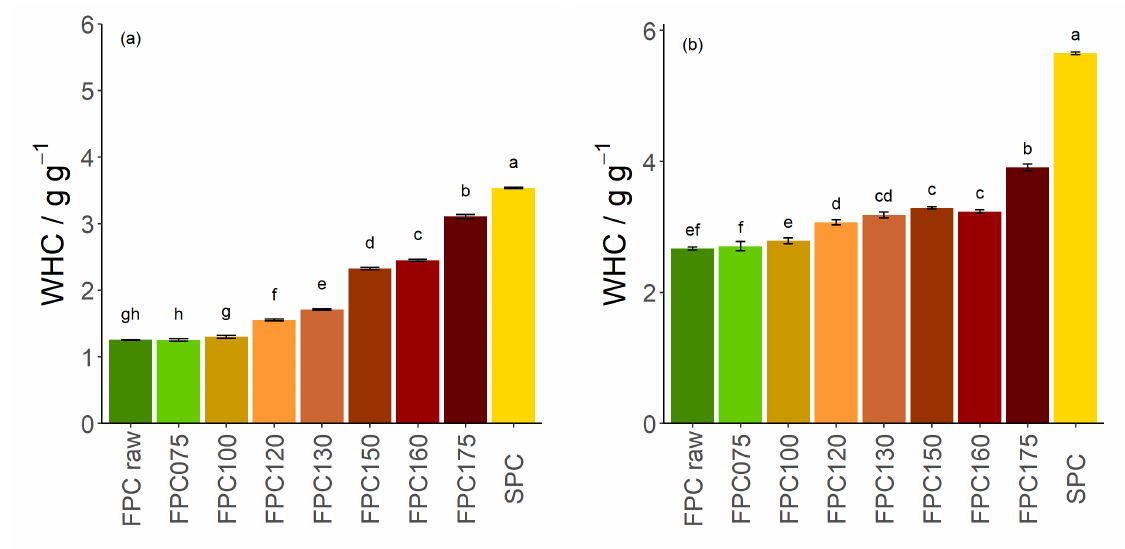
Figure 1. ( a ) Water-holding capacity of the overall powder (Equation (2)) and ( b ) water holding capacity of the insoluble fraction (Equation (3)) of dry-heated and non-dry-heated faba bean protein concentrate (FPC) as well as commercial soy protein concentrate (SPC). n = 3. Water-holding capacity (WHC) of FPC powder dry-heated at up to 100 ◦ C did not show any significant difference from non-dry-heated FPC powder. FPC powder dry-heated at higher temperatures showed an increase in WHC, with 150 ◦ C and 175 ◦ C having the largest effect. The WHC of the insoluble fraction only increased slightly after heat treatment, with the exception of 175 ◦ C ( b